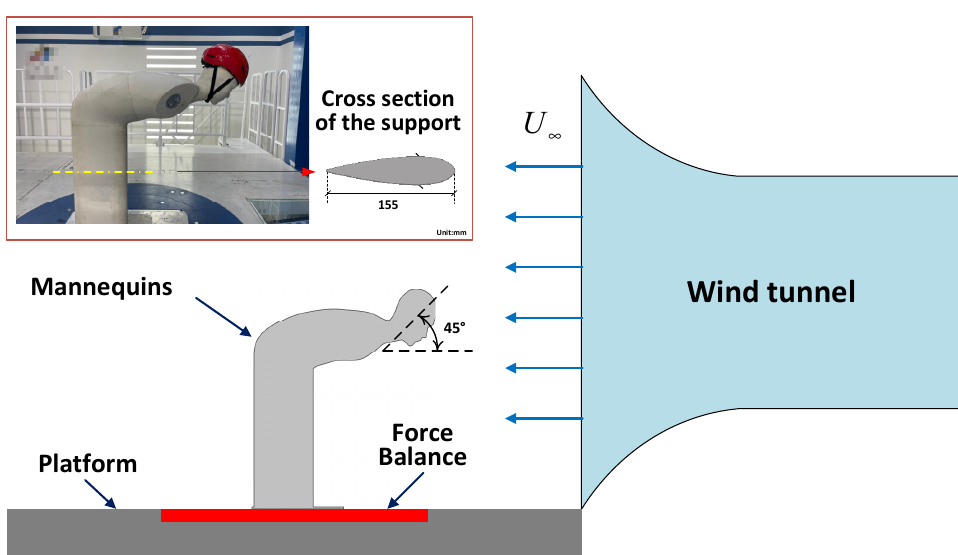
Figure 6. Schematic of the wind tunnel experiment.